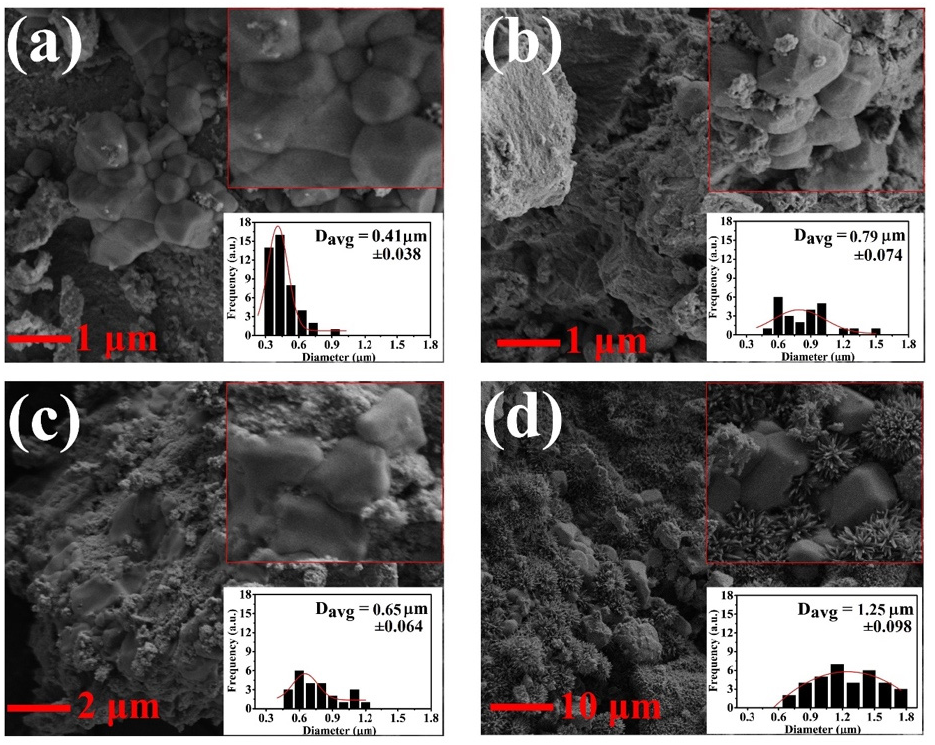
Figure 5. FESEM images of MNPs synthesised at increasing molarities: [( a ): C1; ( b ): C2; ( c ): C3; and ( d ): C4)].